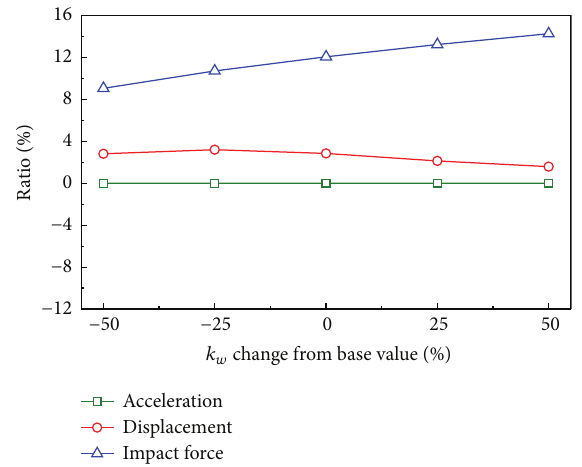
Figure 11: Effect of changing moat wall spring stiffness on structural response.